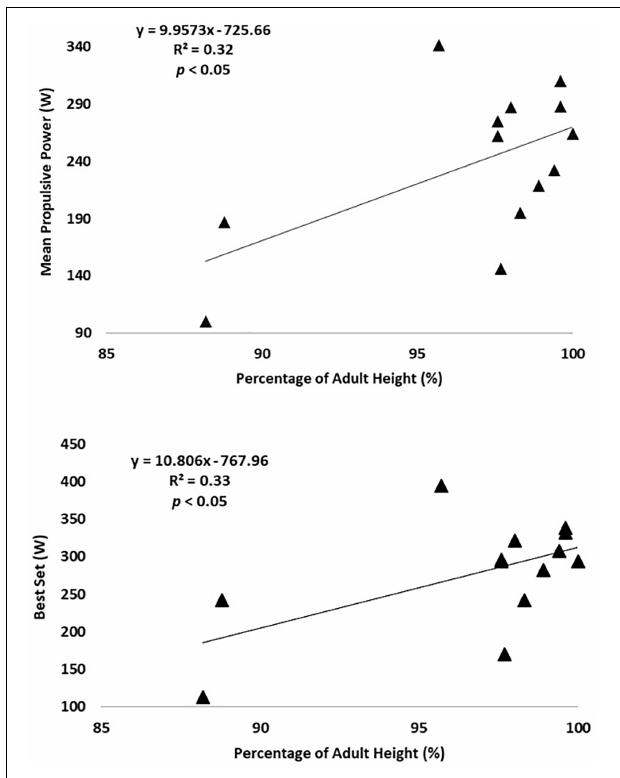
FIGURE 2 | Linear relationship between (A) Mean Propulsive Power and %PAH, and (B) Best Set and